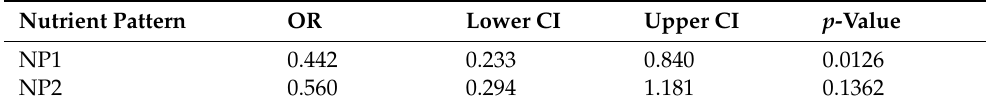
Table 3. Association of NP1 with T1D, adjusted for HLA, race/ethnicity, sex and family history of T1D in the nested case-control study.